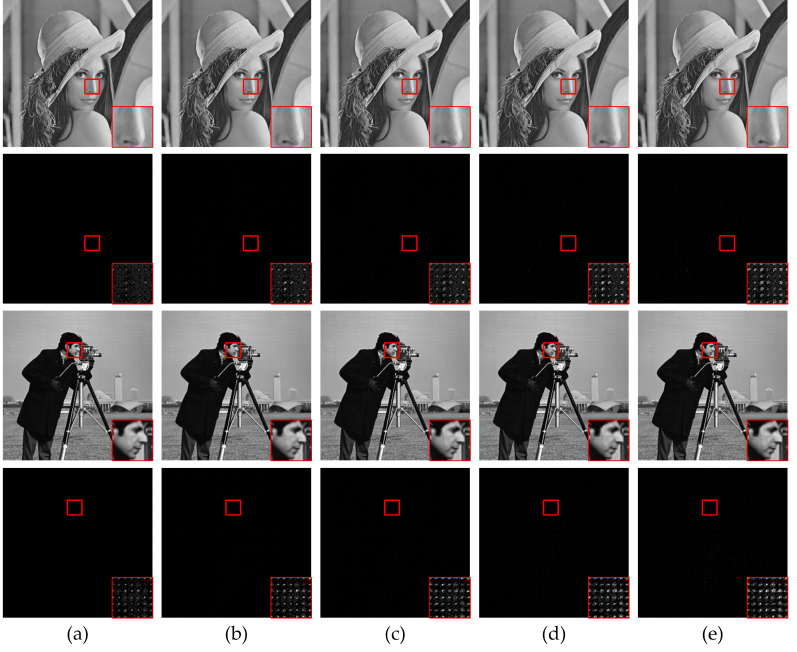
Figure 6. The watermarked images generated under different cases of strength factors α and the difference with the cover images: ( a ) α = 0.2, ( b ) α = 0.4, ( c ) α = 0.6, ( d ) α = 0.8, and ( e ) α = 1.0.